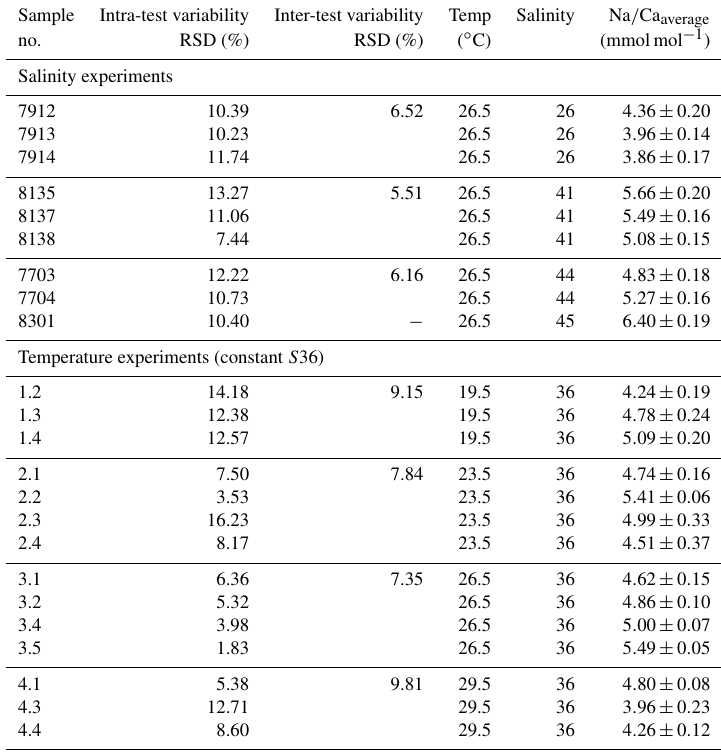
Table B1. Inter- and intra-test Na / Ca variability of cultured T. sacculifer with varying experimental settings. The Na / Ca intra- and inter-test variability is calculated from single averaged electron microprobe maps (Tables 3, 4, 5) within one foraminifer (no.) and between foraminifera (Na / Ca average ± standard error of the mean) from the same experiment. The variability is expressed as the relative standard deviation (RSD) in percent. Annual salinity and temperature data for in situ grown foraminiferal calcite (F-3, F-4) in the open ocean were taken from WOA13 (Zweng et al., 2013; Locarnini et al.,